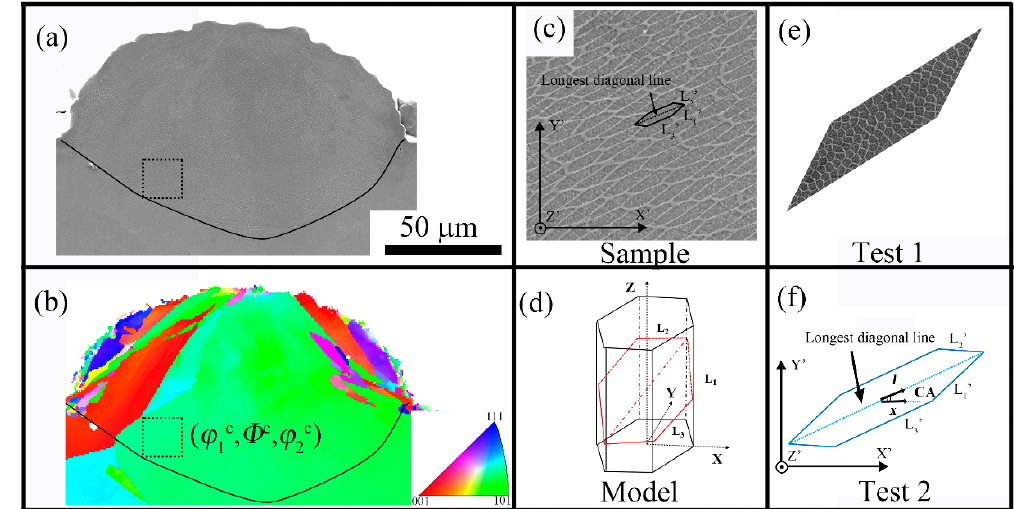
Figure 1 . The process to calculate the growth direction of the substructure in the single track. ( a ) is the etched transverse cross section and ( b ) is the EBSD map corresponding to the section. The boundary of the track is marked out by the black dot line. ( c ) is the region sampled from the transverse cross section, and the outline of the substructure is light gray. A real hexagon is selected from this region, whose boundary is marked out by black line. ( d ) is the model of a hexagonal prism with the top surface of a regular hexagon. ( e ) is the projected figure of the sampled region. ( f ) is the transformative hexagon sectioned from the hexagonal prism according to the growth direction.